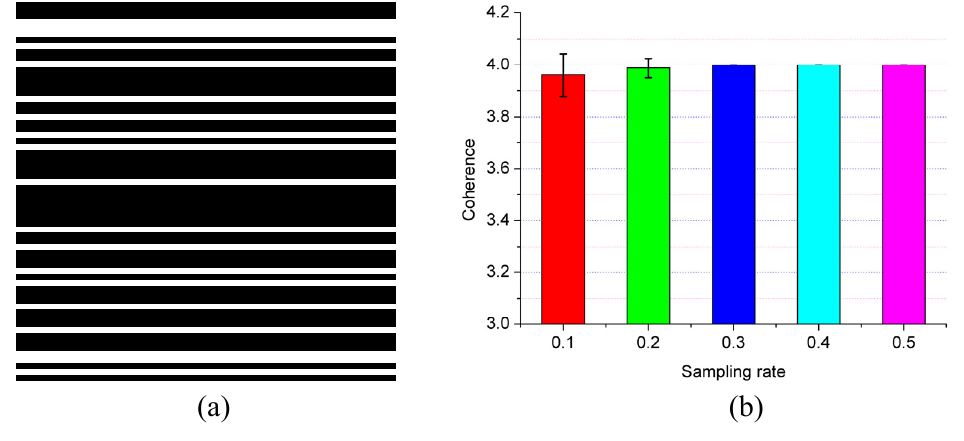
Figure 6. Coherence of wavelet and FT. ( a ) One sampling pattern in the indirect dimension with sampling rate ρ = 0.30 (fully sampled points in the indirect dimension = 64); ( b ) coherences for different sampling rates. The symmlet wavelet is N 1 with four decomposition levels and eight vanishing moments is chosen as a typical wavelet for test, which is also the typical wavelet in [16]. Error bar stands for the standard deviation when repeating 10 times at each sampling rate.